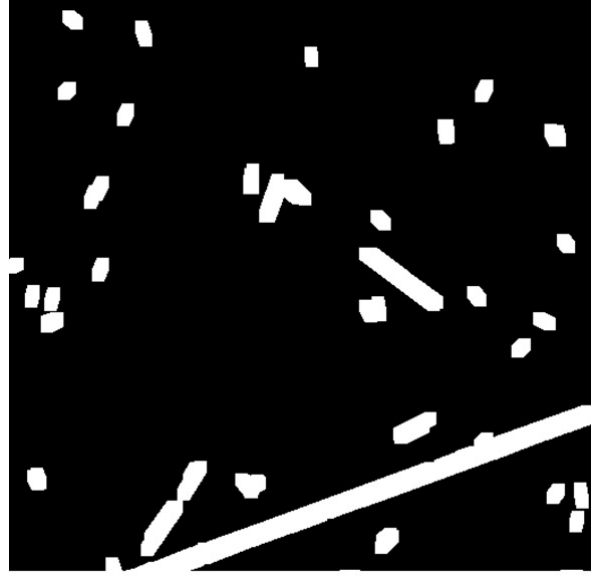
Figure 6. Merged line mask undergone the dilation morphological operation, note that the asteroid path is not included in this